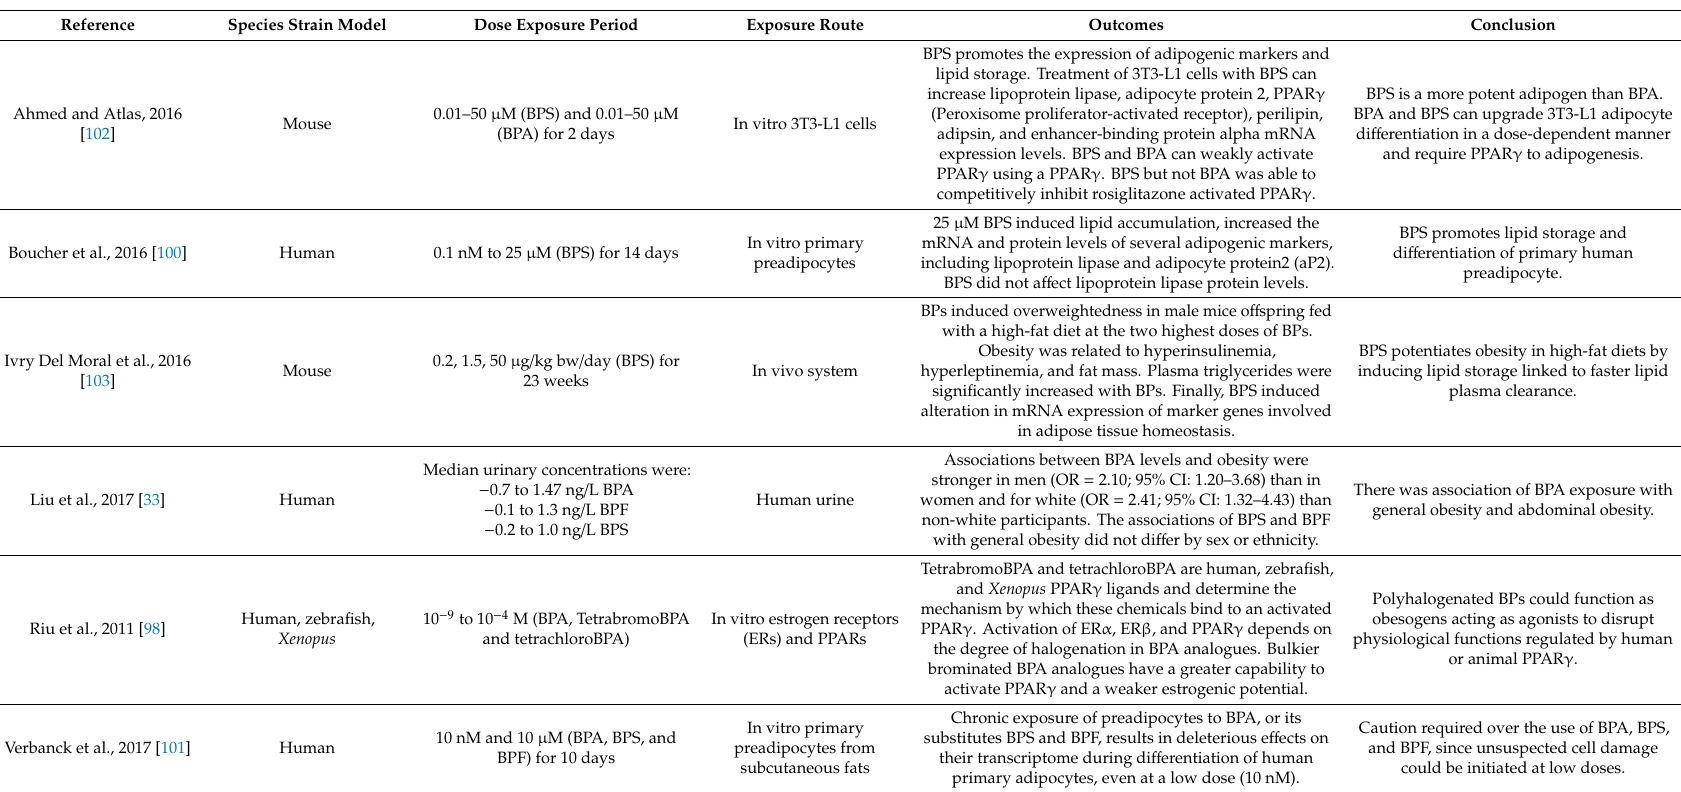
Table 3. Studies about obesogenic e ff ects of